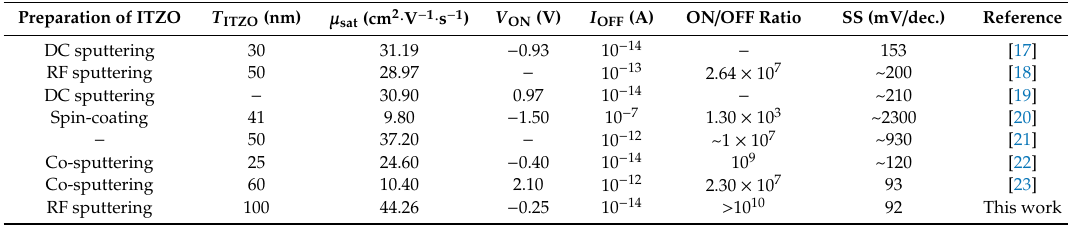
Table 2. Comparison of the electrical characteristics of various T ITZO devices and other ITZO-based TFTs in the literature.